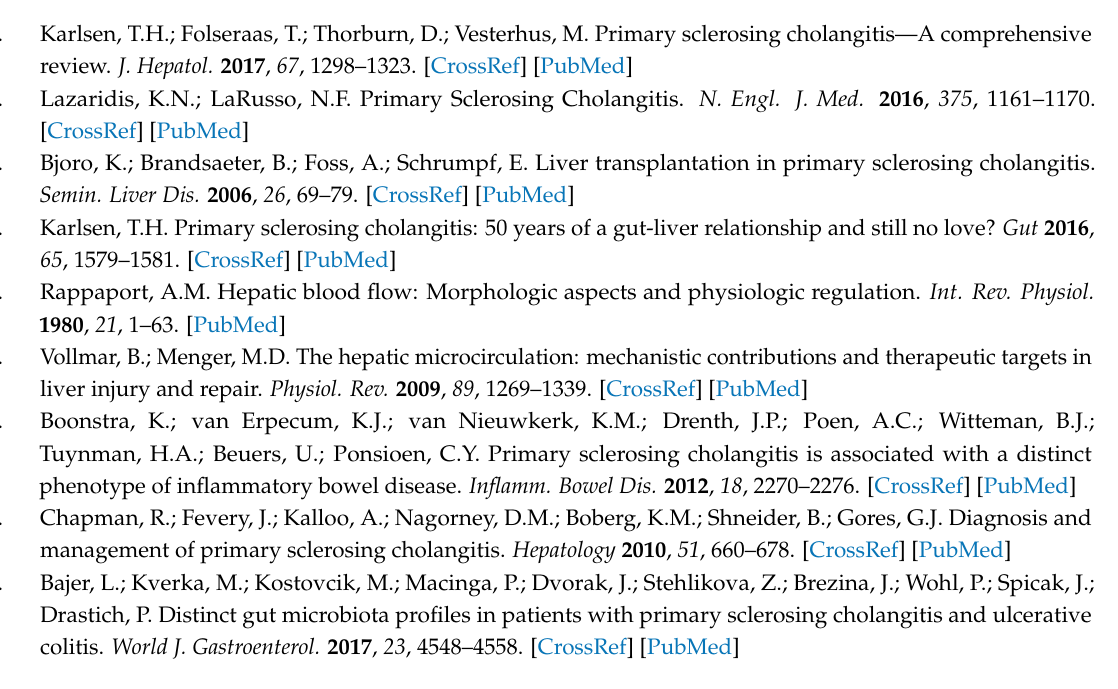
bile metabolite sets. Table S1. Mann–Whitney (two-tailed) U test results for identification of differentially abundant metabolites in portal serum metabolomic data. Table S2. Mann–Whitney (two-tailed) U test results for identification of differentially abundant complex lipids in portal serum lipidomic data. Table S3. Mann–Whitney (two-tailed) U test results for identification of differentially abundant metabolites in bile metabolomic data. Table S4. Mann–Whitney (two-tailed) U test results for identification of differentially abundant complex lipids in bile lipidomic data. Table S5. log 2 -transformed relative intensities (total intensity normalization) for chemicals in portal serum metabolomic data. Table S6. log 2 -transformed relative intensities (total intensity normalization) for chemicals in portal serum lipidomic data. Table S7. log 2 -transformed relative intensities (total intensity normalization) for chemicals in bile metabolomic data. Table S8. log 2 -transformed relative intensities (total intensity normalization) for chemicals in bile lipidomic